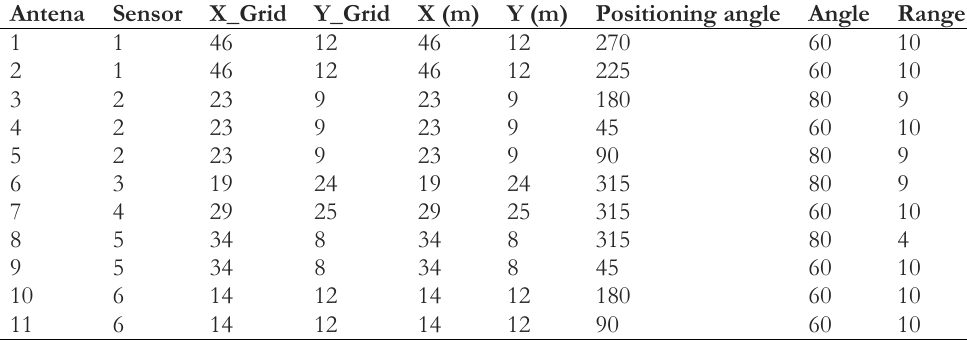
Table 10. Optimized antenna design for scenario